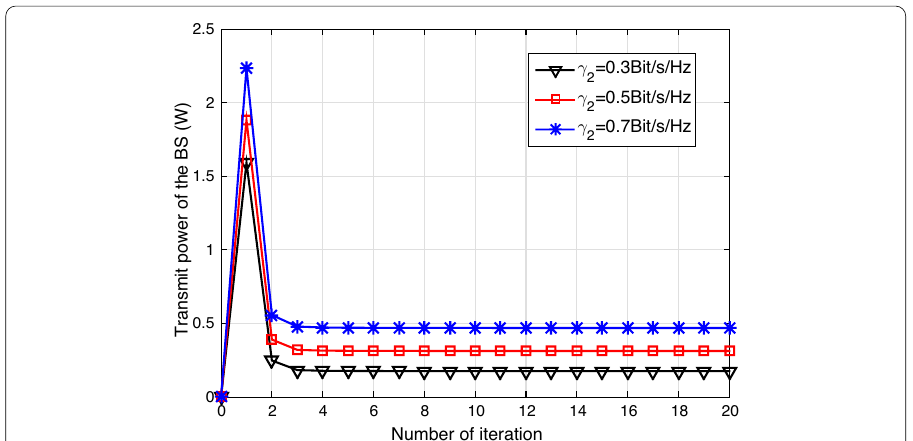
Fig. 3 The minimum transmission power of the BS versus the number of iterations